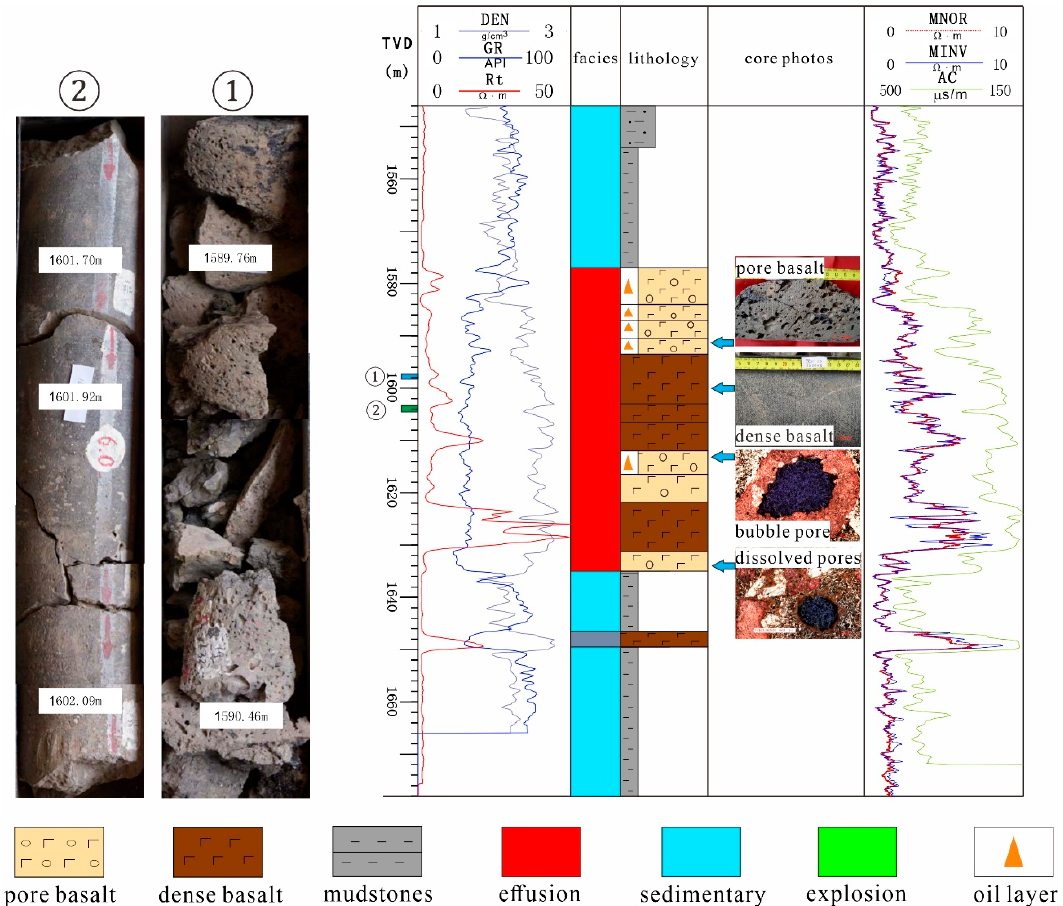
Figure 13. The comprehensive histogram of Jun 21–23 and the characteristics of rock cores and